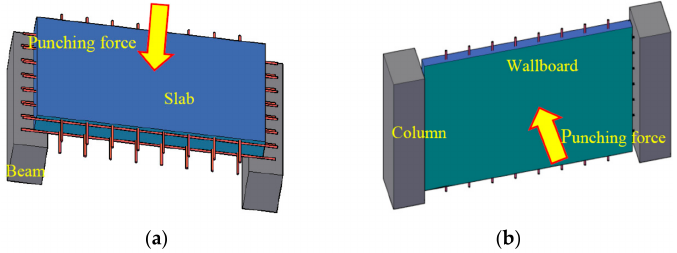
Figure 1. Punching stress state of different components. ( a ) Floor slabs with double row reinforcement; ( b ) Thin wallboard with single-layer